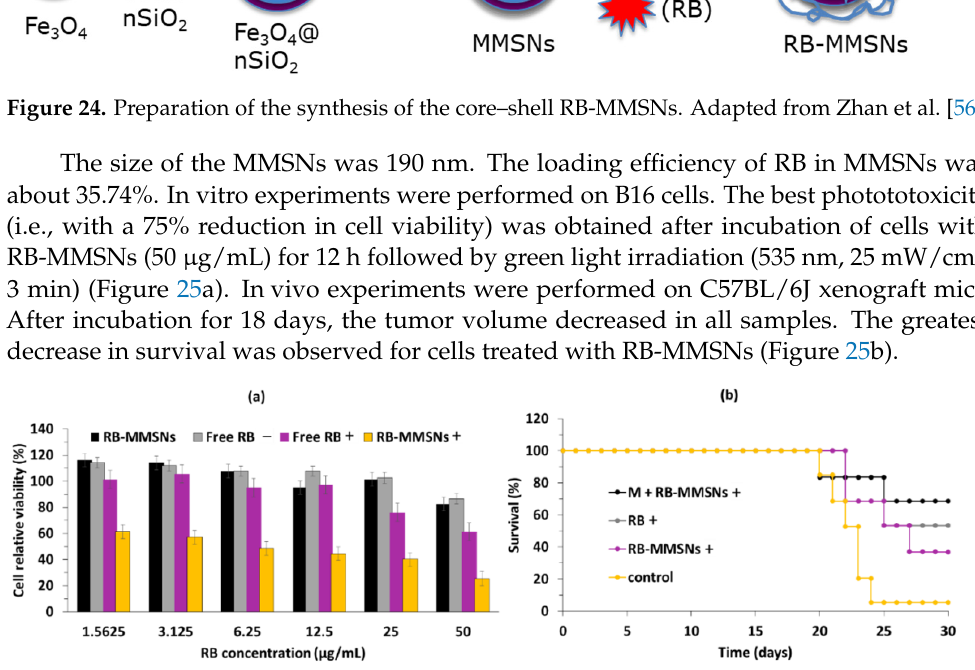
Figure 25. ( a ) Relative cell viability of B16 cells treated with various concentrations of MMSNs, RB–MMSNs, and RB with (+) or without ( − ) green light irradiation (532 nm, 25 mW/cm 2 , 3 min). ( b ) Survival curves of groups with different treatments (532 nm, 25 mW/cm 2 , 3 min) (control, RB+, RB–MMSNs+ and M + RB–MMSNs+). Adapted from Zhan et al. [56]. Liu et al. [57] synthesized MSNs embedding carbon dots and RB in a core–shell structure with an average diameter of 104 nm. The core–shell structure prevented the self- aggregation of carbon dots and RB, enhanced the photoluminescence and 1 O 2 production, and allowed drug loading. The in vitro cytotoxicity of the conjugate was evaluated on H1299 cancer cells by MTT assay using laser light irradiation (540 nm, 300 mW/cm 2 , 5 min), and a reduction in cell viability of 90% was found. The conjugate presented a high capacity for imaging-guided chemo/PDT when DOX was incorporated into the NPs. Yan et al. [58] designed MSNs conjugated with RB via an amide bond and with DOX via a pH-responsive linker (MSN-AH-DOX@RB) with a diameter of approximately 200 nm. The MSNs presented good biocompatibility and stability in an aqueous medium. DOX release in the acidic tumor microenvironment was highlighted when decreasing pH from 7.4 to 5.5. The cellular uptake of RB and DOX was demonstrated in MCF-7 cells. MSNs (0.5 mg/mL) showed minimal (~2%) dark cytotoxicity. MSN-AH-DOX@RB presented a higher cellular phototoxicity when evaluated by CCK-8 assays compared to control (RB or DOX or MSN-AH@RB or MSN-AH@DOX). 1 O 2 production was observed via SOSG. A laser at a wavelength of 532 nm (0.5 W/cm 2 ) was used for 5 min at 1 min intervals for every 1 min of light exposure to illuminate MCF-7 incubated with MSN-AH- DOX@RB. The highest phototoxicity (90% efficiency) was observed for MSN-AH- DOX@RB plus laser irradiation for 5 min, showing a synergic chemo/PDT effect. Jain et al. [59] reported the elaboration of silica-coated Gd 3 Al 5 O 12 :Ce 3+ nano-platforms loaded with RB with a size of 74.13 ± 9.04 nm. 1 O 2 production in water was detected using DPBF, and was higher for RB-loaded NPs than for RB. In vitro experiments were